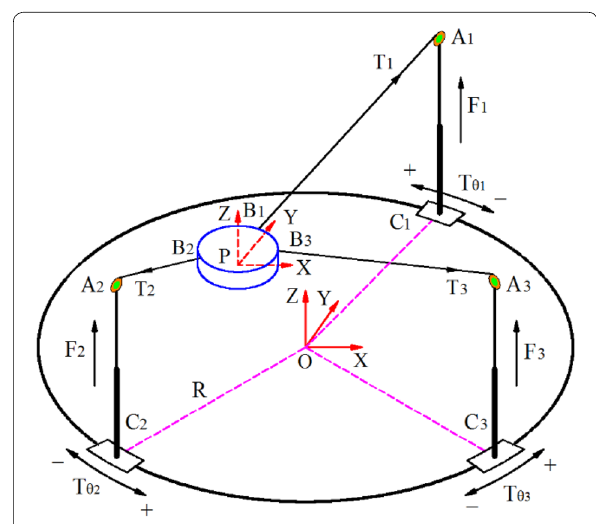
Figure 2 Force analysis diagram of the